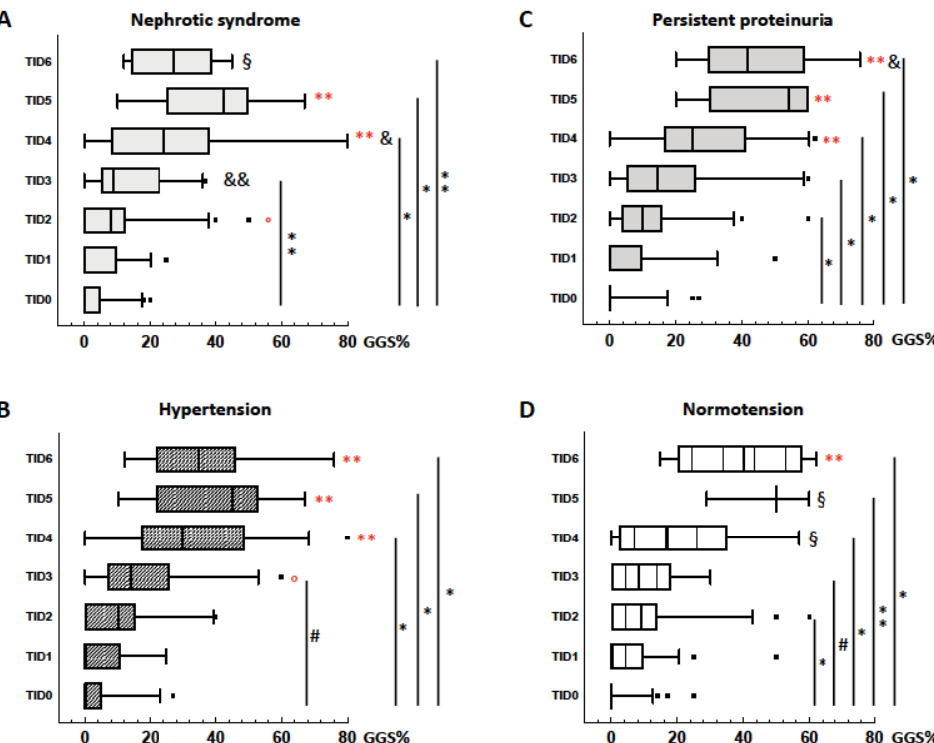
Figure A1. Severity of tubulointerstitial damage (TID) by global glomerulosclerosis (GGS%) in the patients with nephrotic syndrome (Panel A ), arterial hypertension (Panel B ), persistent proteinuria (Panel C ), and normotension (Panel D ). *: p < 0.0001 vs. TID 0; #: p = 0.03 vs. TID 0; **: p = 0.01 vs. TID 0; §: p = 0.04 vs. TID 1; **: p = 0.01 vs. TID 1; & p = 0.02 vs. TID 2; ° : p = 0.02 vs. TID 5; &&: p = 0.04 vs. TID 5.